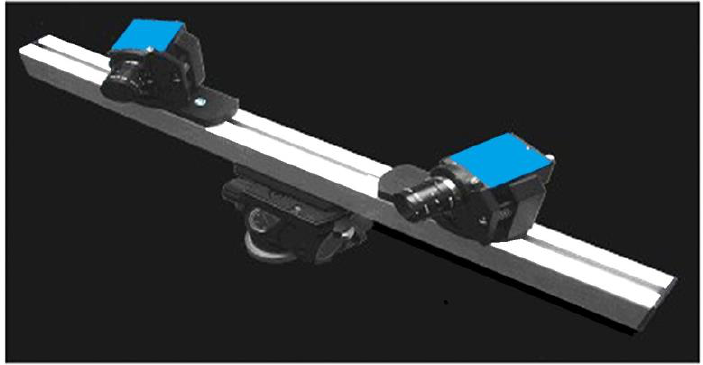
Figure 3. The main components of the VIC-3D system